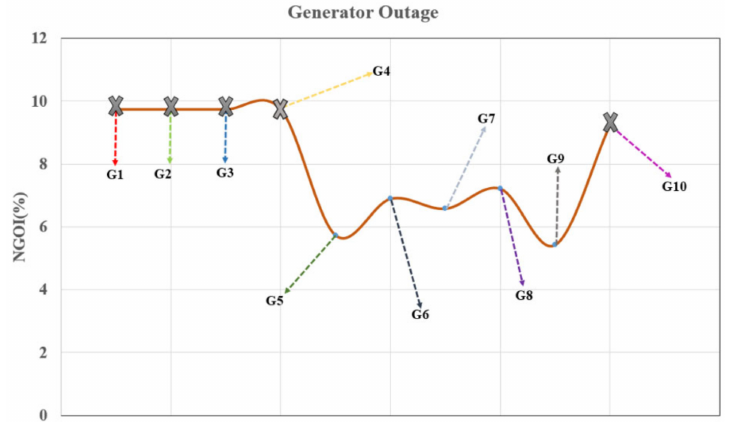
Figure 9. The NGO indexes of generators.